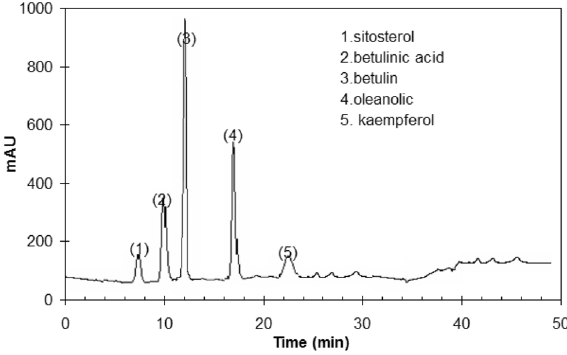
Figure 1. HPLC of BLE